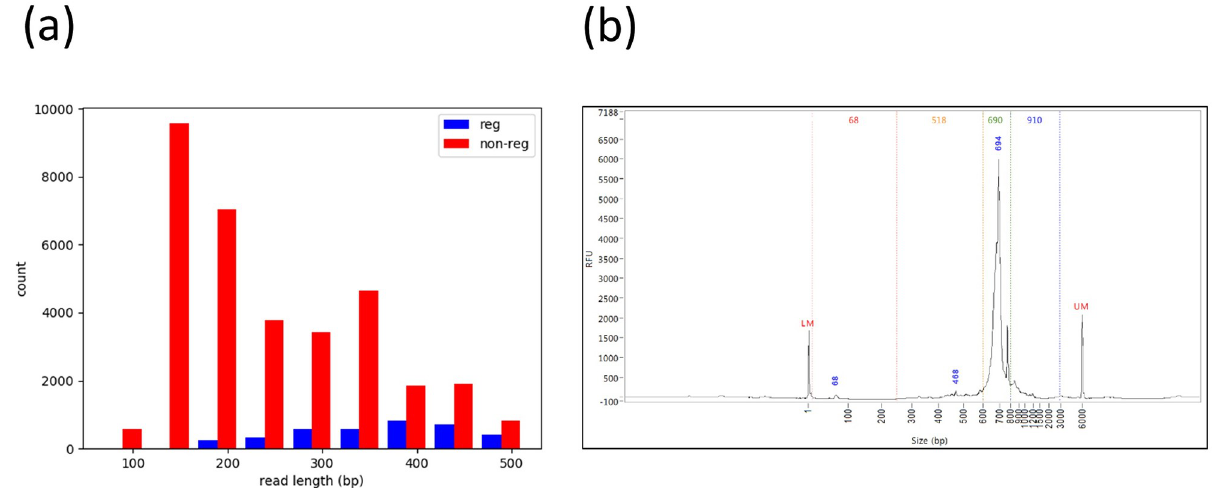
Fig 1. Length distribution of 5’-RACE products based on (a) the merged reads and (b) fragment length analysis of the C-A library. In Fig 1a, blue and red indicate regular and non-regular TCR- β sequences respectively.